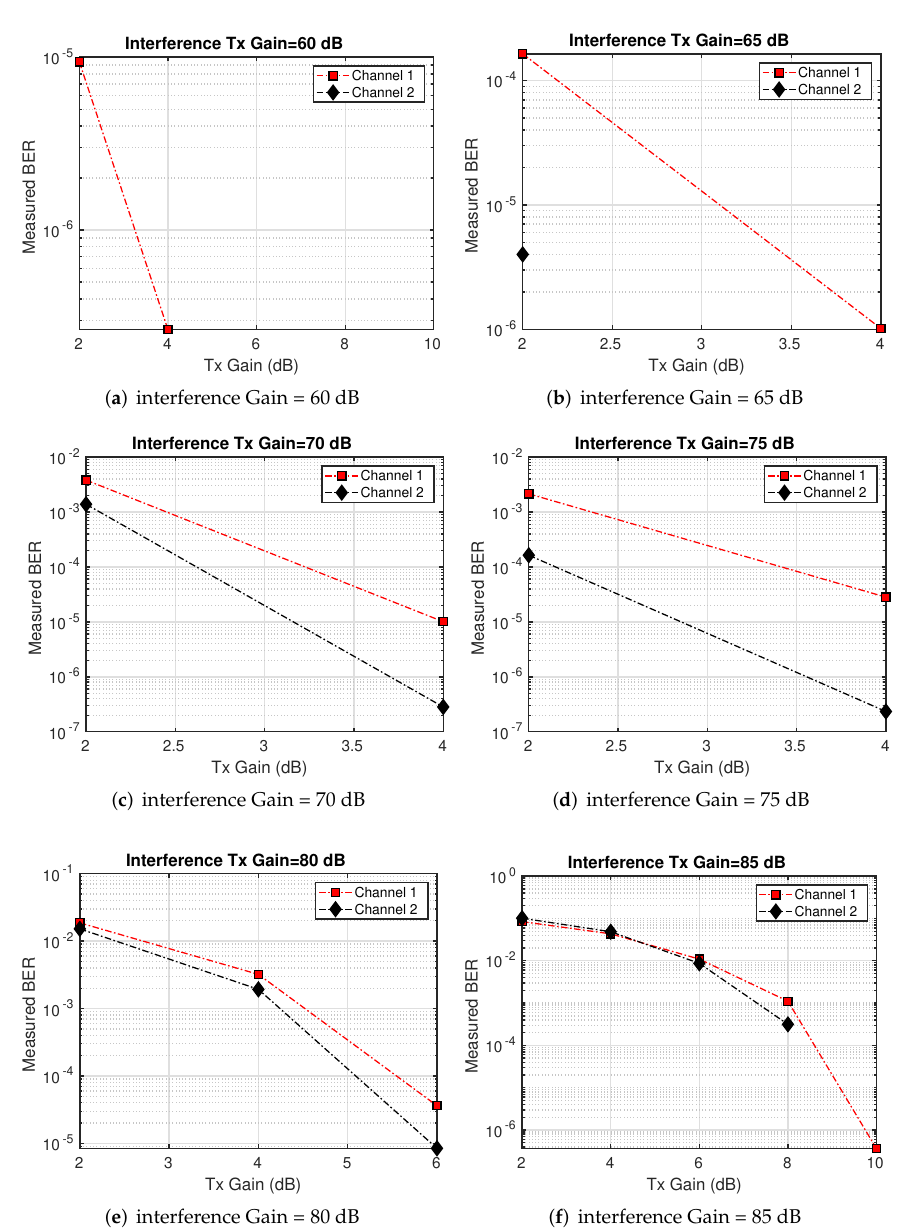
Figure 10. Measured MIMO BER of channel 1 and channel 2 in the presence of the MIMO interference when the metal enclosure was loaded with ten pieces of RF absorber